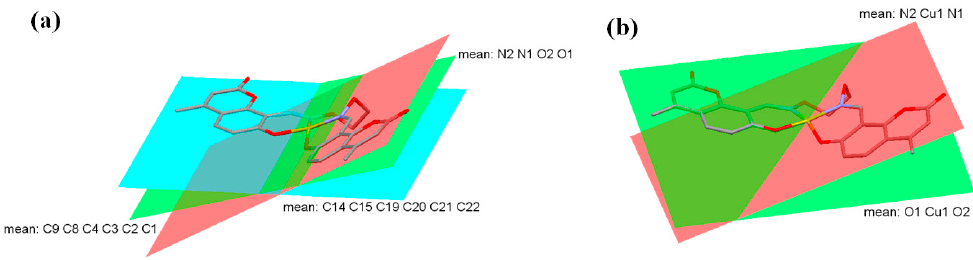
Figure 5. ( a ) View of the dihedral angles between the benzene rings and the N 2 O 2 basal plane of complex 1 ; ( b ) View of the dihedral angles between planes CuN 2 and CuO 2 of complex 1 .